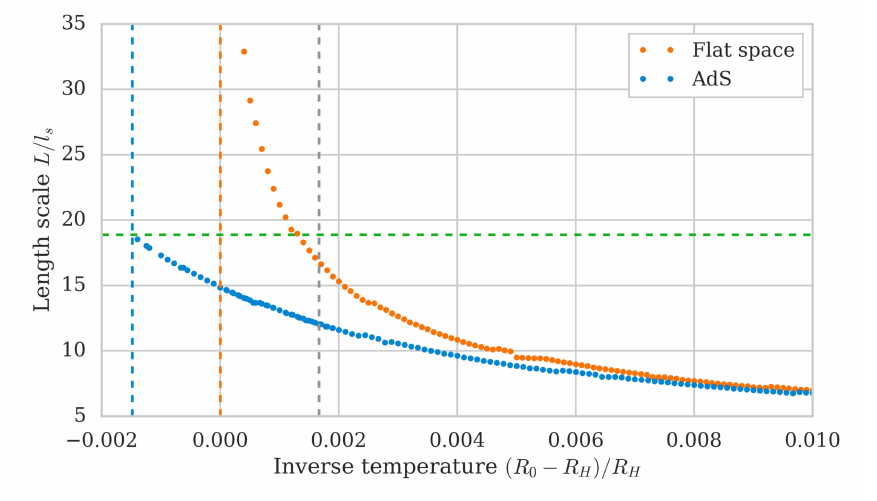
Figure 5 . Numerical estimation of the string star length scale L (in string units) as a function √ of ( R ) /R . The length scale is defined as the coordinate ρ at which χ ( ρ ) loses 1 / e of its 0 − R H H amplitude at ρ = 0 . The numerical calculation was done for the d = 3 heterotic string. In blue is the AdS solution with l = 600 , and in orange the flat space solution. The gray vertical line ads /l s is the temperature scale around which the AdS solutions significantly deviate from flat space. The orange vertical line is the flat space Hagedorn temperature R , and the blue vertical line is the H AdS Hagedorn temperature R . The horizontal green line is the critical length scale L c c